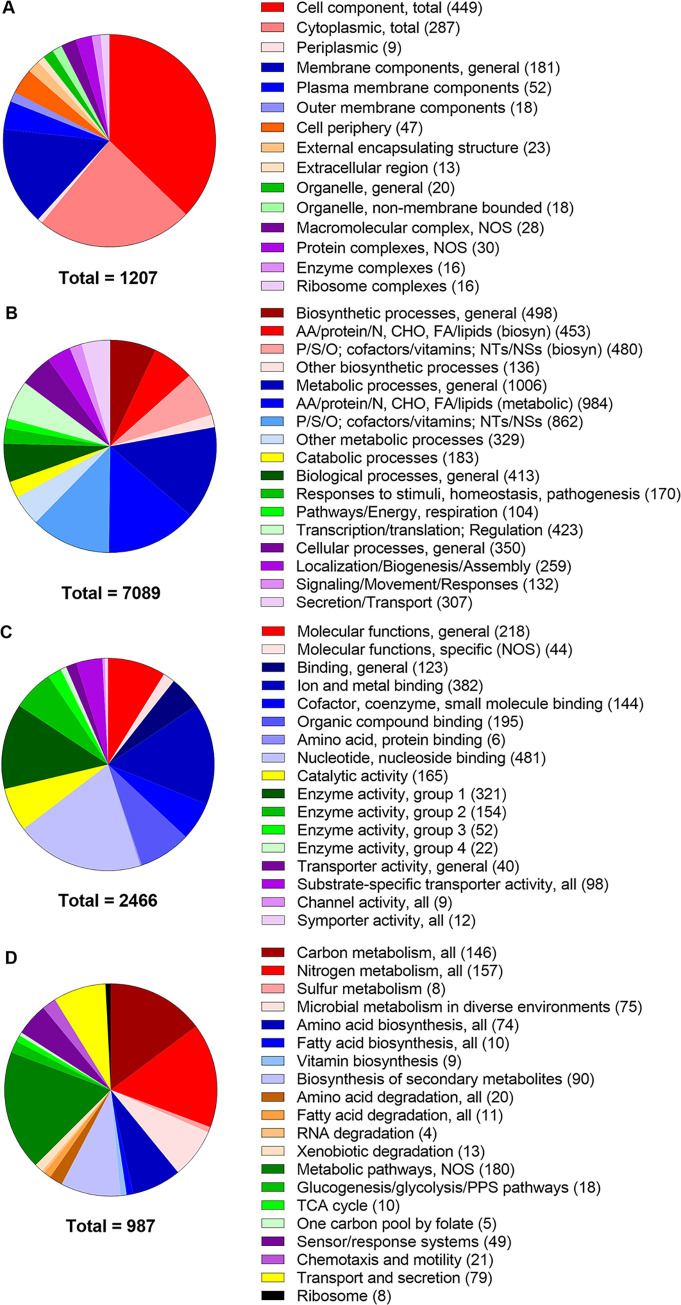
Gene Ontology (GO) functional terms assigned to the products of the 1085 differentially expressed genes.The 1085 genes whose expression was up- or downregulated by the growth of PAO1 in WBHVs compared to its growth LBB were analyzed by GO enrichment analysis using ShinyGO v0.61 and the PAO1 reference genome from the Pseudomonas Genome Database. The GO and KEGG pathway terms were considered to be significantly enriched if their false discovery rate p value was <0.05. (A) Cellular components (1207 terms out of 6533 terms were considered significant), (B) biological processes (7089 of 33620), (C) molecular functions (2466 of 12341), and (D) KEGG pathways (987 of 3711). In all four sections, some genes were assigned more than one term and most terms were assigned to more than one gene. AA, amino acids; CHO, carbohydrates; enzyme group 1: transferases, oxoreductases, hydrolases; enzyme group 2: peptidases, lyases, ligases, phosphorylases; enzyme group 3: racemases/epimerases, synthases, oxidases, dehydrogenases, dehydratases; enzyme group 4: carboxylases, isomerases, transaminases, dismutases; FA, fatty acids; N, nitrogen; NOS, not otherwise specified; NTs/NSs, nucleotides/nucleosides; PPS, pentose-phosphate shunt; P/S/O, phosphorus/sulfur/oxygen; TCA, tricarboxylic acid cycle.